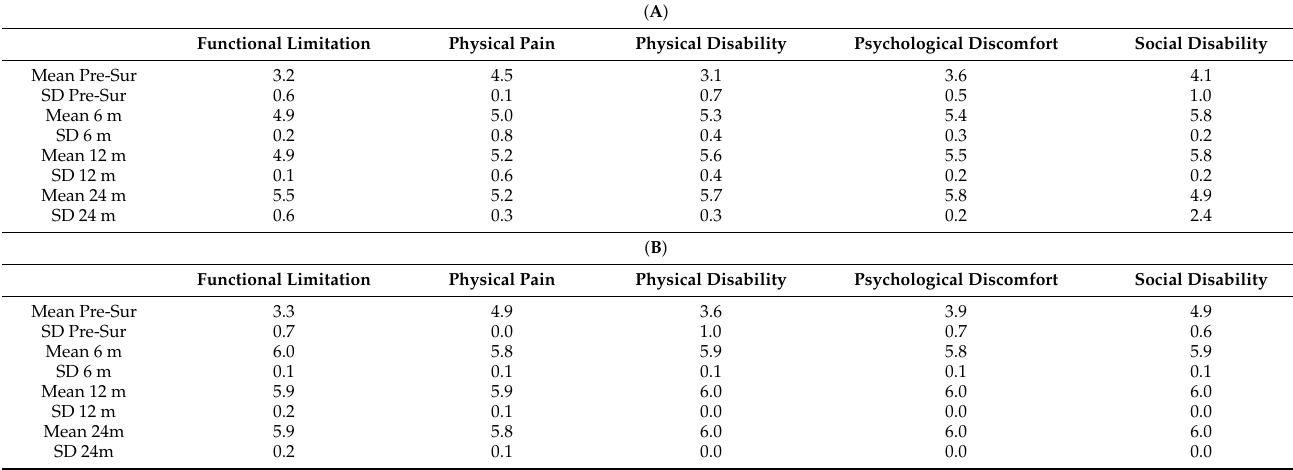
Table 3. ( A ) Control group. Mean values (score) and SDs of Oral Health Impact Profile (OHIP) domains for maxillary full-arch FDPs in control group at pre-surgical time, 6 months, and 12 months. ( B ) Short group. Mean values (score) and SDs of OHIP domains for maxillary full-arch FDPs in short group at pre-surgical time, 6 months, and 12 months. ( A